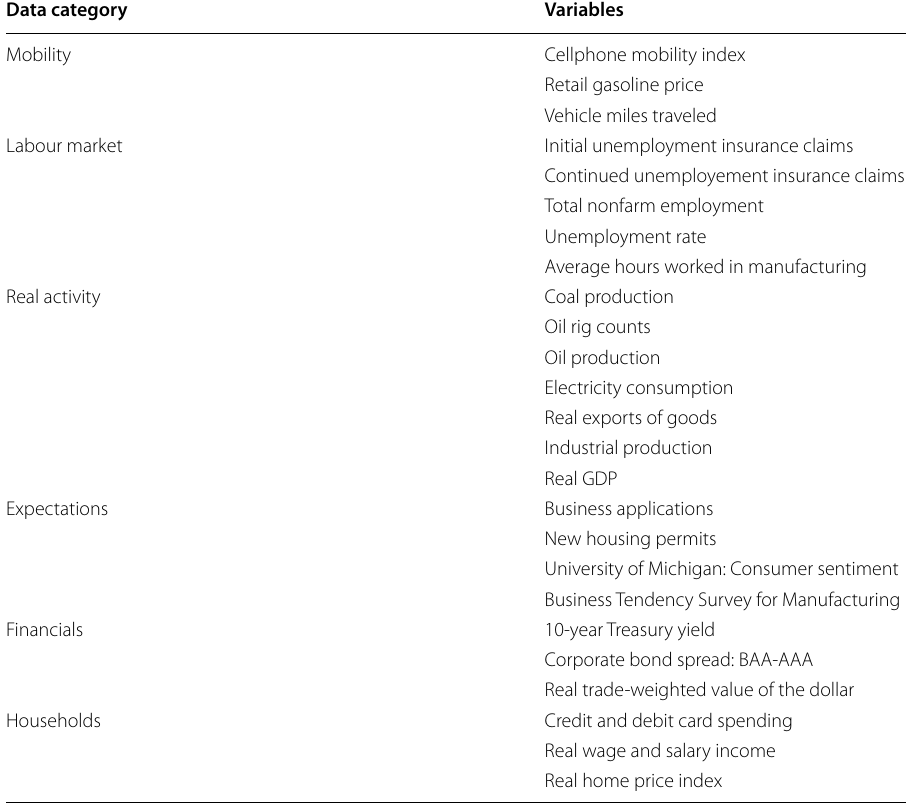
Table 9 Dataset for U.S. economic conditions